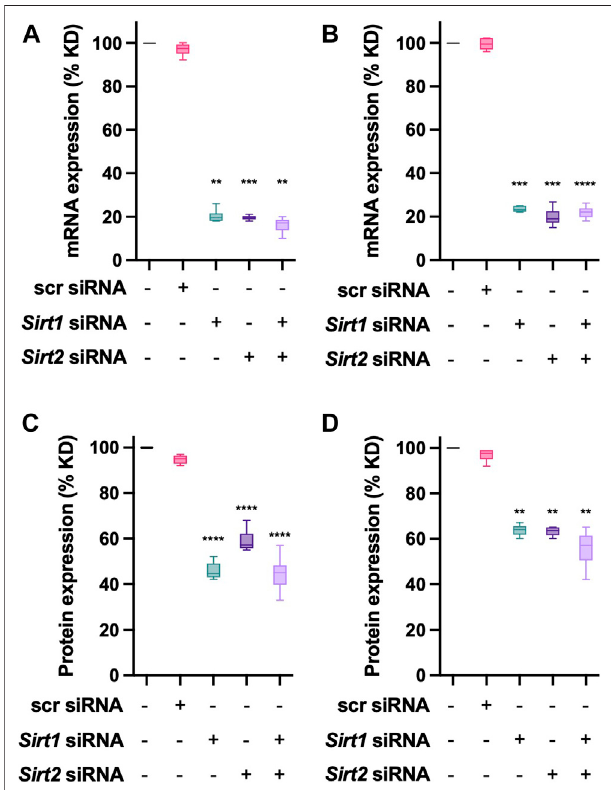
FIGURE 4 | Sirt1 and Sirt1 knockdown in breast cancer cells. (A) MDA- MB-231 cells or (B) ZR-75-1 cells were transfected with control ( scrambled ), Sirt1 or Sirt2 siRNAs. Then the relative expression of the target genes was evaluated after a 48-h transfection. (C) MDA-MB-231 or (D) ZR-75-1 cells, were transfected for 72-h, at that time the protein expression of the target protein was evaluated. Data is presented as the mean ± SEM of three independent experiments. **, p < 0.01; ***, p < 0.001; ****, p < 0.0001 compared vs. scr